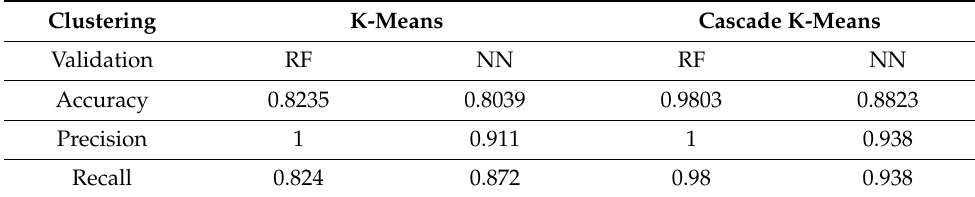
Table 14. Comprehensive comparison of two clustering